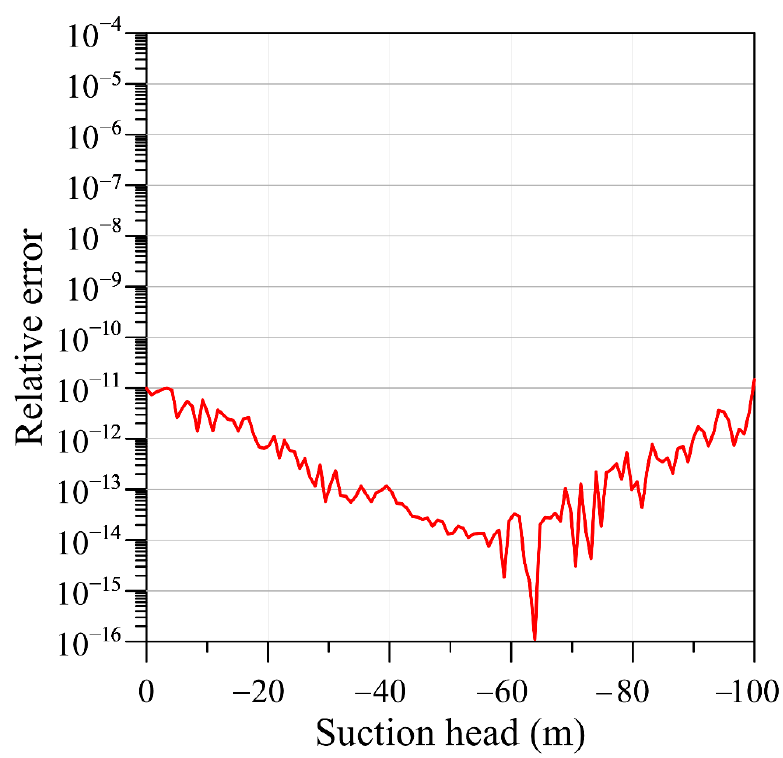
Figure 6. The relative error between the scattered data by the Gardner model and the RBF.